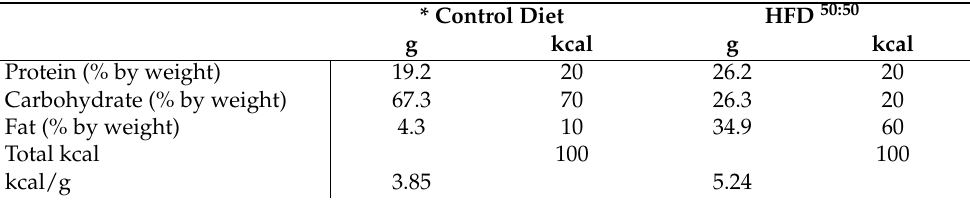
Table 2. Rodent diet with 10 or 60 kcal% fat and modification to fat sources and fat level. * The control diet was not investigated in this study and is included for reference purposes only. ** Vitamin mix (V1001): vitamin A acetate (500,000 IU/g), vitamin D3 (100,000 IU/g), vitamin E acetate (500